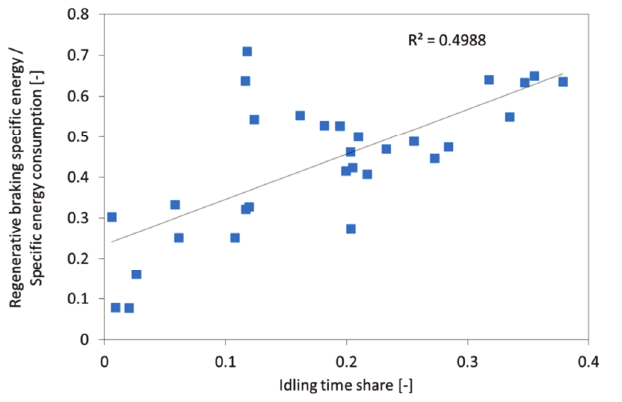
Fig. 6. Relation between the idling time share and the share of the regener- ative braking specific energy